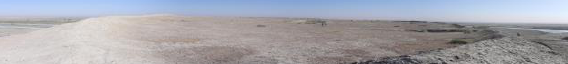
Figure 8 - Panoramatic view on the citadel of Kushaf from the SW corner